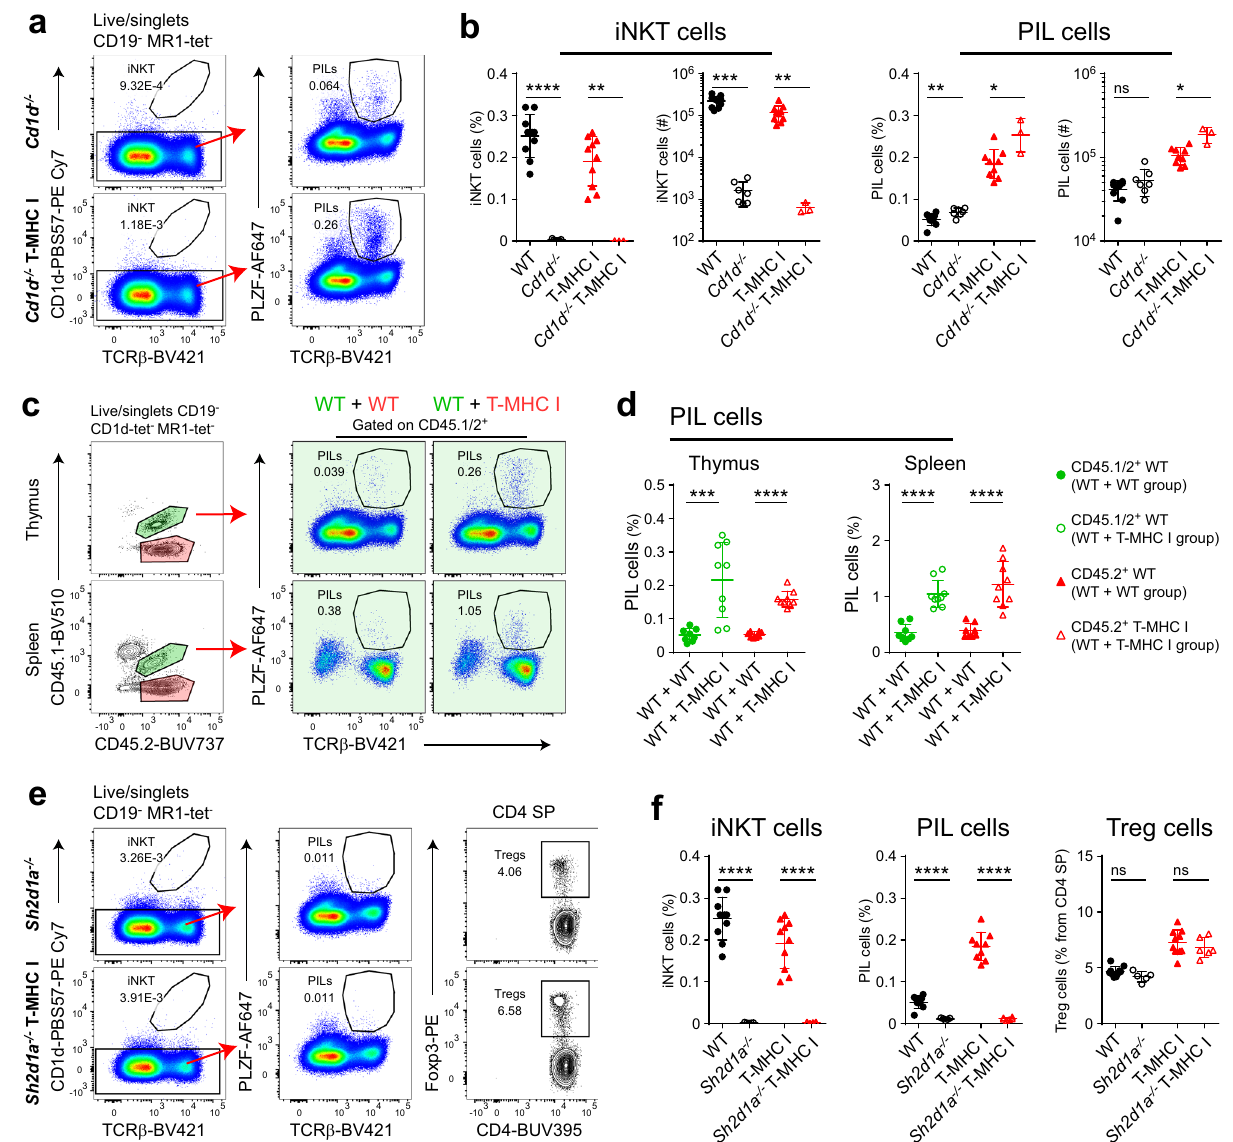
Fig. 3 PIL T cells are SAP dependent and require MHC I in a cell-extrinsic manner. a Representative fl ow cytometry plots of total thymocytes from Cd1d − / − and Cd1d − / − T-MHC I mice. b Thymic iNKT and PIL cell frequency and number comparison between WT and Cd1d − / − , and T-MHC I and Cd1d − / − T- MHC I mice. c Representative fl ow cytometry plots from a set of unequal bone marrow (BM) chimeric mice 8 weeks post transplantation. WT CD45.1 + mice were lethally irradiated and transplanted with a mix of WT CD45.1/2 + and T-MHC I CD45.2 + bone marrow at a ratio of 1 : 10. This experimental group is depicted as WT + T-MHC I group. In the control group, mice were transplanted with a mix of WT CD45.1/2 + and WT CD45.2 + bone marrow at a ratio of 1 : 10. This experimental group is depicted as WT + WT group. Shown are representative fl ow cytometry plots displaying the gating strategy from WT + WT group (in the left two panels). In the right four panels (in green) are shown representative plots displaying PIL cell frequencies (gated on WT CD45.1/2 + ) from the WT + WT group (on the left) and WT + T-MHC I group (on the right). PIL cell frequency evaluation is shown in d . e Representative fl ow cytometry plots of total thymocytes from Sh2d1a − / − (SAP de fi cient) and Sh2d1a − / − T-MHC I mice. iNKT, PIL, and T reg cell frequency are shown in f . b , d , f Each point represents one animal: n = 10 animals per group (WT and T-MHC I groups), n = 7 animals ( CD1d − / − group), n = 3 animals ( CD1d − / − T- MHC I group), n = 8 animals (WT + WT group), n = 9 animals (WT + T-MHC I group), n = 5 animals ( Sh2d1a − / − group), and n = 6 animals ( Sh2d1a − / − T-MHC I group). Data are representative of four in a , b , e , f and two in c , d independent experiments. Unpaired two-tailed Mann – Whitney test was performed in b , d and an unpaired two-tailed Student ’ s t -test was performed in f ; ns, not signi fi cant ( p ≥ 0.05), * p < 0.05, ** p < 0.01, *** p < 0.001, and **** p < 0.0001. Data are presented as mean values ± SD. Source data are provided as a Source Data fi